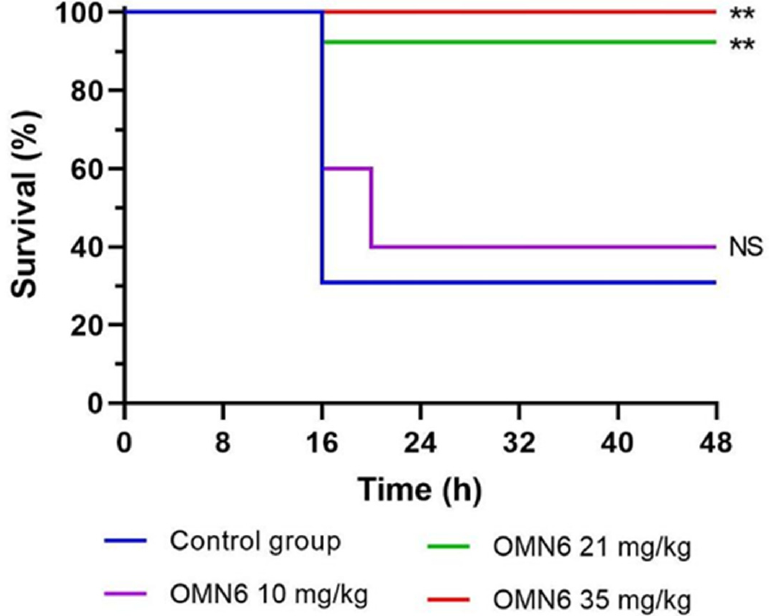
Figure 2. Efficacy of OMN6 in a mouse bacteremia survival model for up to 48 h. Neutropenic CD-1 female mice were intraperitoneally inoculated with A. baumannii MDR strain ATCC BAA-1793 (0.5 × 10 6 CFU/mouse). Two hours post-inoculation, OMN6 was administered by an intravenous bolus of four separate doses (q1h) at 10, 21, or 35 mg/kg. OMN6 was administered only during the first 24 h of the experiment. Saline solution was administered for the control group ( n ≥ 5, NS—Not Significant, ** p < 0.01; according to Log-rank (Mantel–Cox) statistical test. Supplementary information about the resistance pattern of the bacterial strain used in this study is displayed in Table S4.